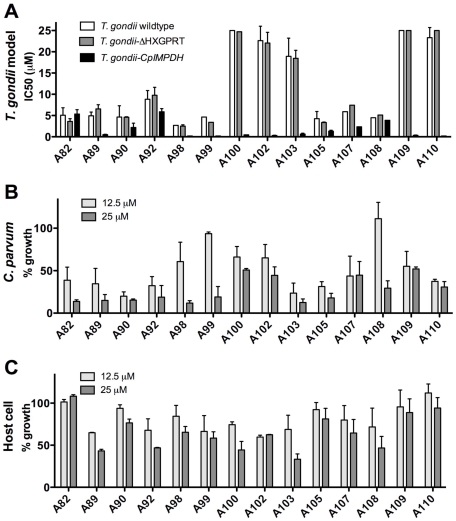
Identification of derivatives with high potency and selectivity in the T. gondii-CpIMPDH model.
A shows EC50 values for a selection of inhibitors assayed in the T.gondii-CpIMPDH parasite model and demonstrates a range in inhibitor selectivity and potency. Compounds were assayed in triplicate and growth inhibition was calculated on a day during the exponential phase of growth, by normalisation to wells receiving DMSO alone. The EC50 calculation was performed as described in Figure S2. Compounds A82, A89, A90, A92, A102, A103, A105, and A110 were selected for rescreening and the mean values for at least 2 replicate experiments are shown. The inhibitors were then tested for inhibition of C. parvum (B) and host cell growth (C). For B percent C. parvum growth was determined using the high-content imaging assay as detailed in Figure 4, with the inhibitor at 12.5 µM and 25 µM. A subset of compounds was selected for re-screening and the mean over at least 2 replicate experiments is shown for compounds A90, A92, A98, A103, A105, A109 and A110. C shows percent host cell growth assayed using the fluorescent HCT-8 cell line with inhibitors at 12.5 µM and 25 µM. GFP expressing HCT-8 cells were seeded at 4000 cells per well into 96-well plates and triplicate wells were spiked with test compound and fluorescence was measured daily for 7 days. Percent growth inhibition was calculated on a day during the exponential phase of growth, by normalisation to wells receiving DMSO alone. Inhibitors A89, A90 and A92 were selected for re-screening and the mean over at least 2 replicate experiments is shown.